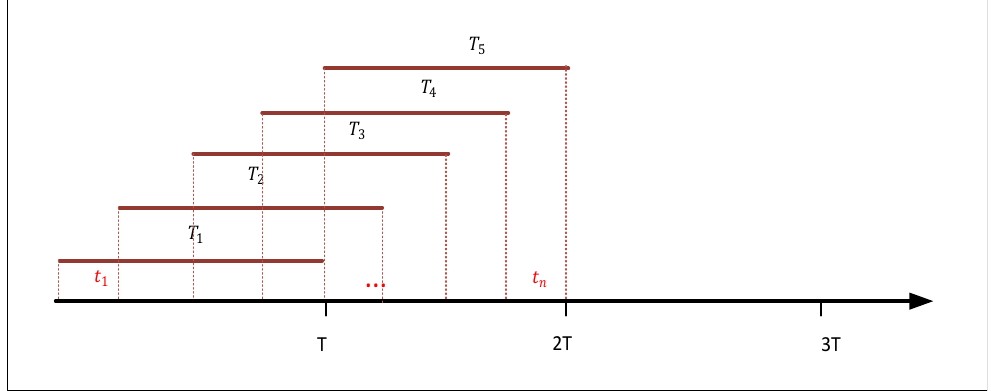
Figure 5. Sliding Time Window